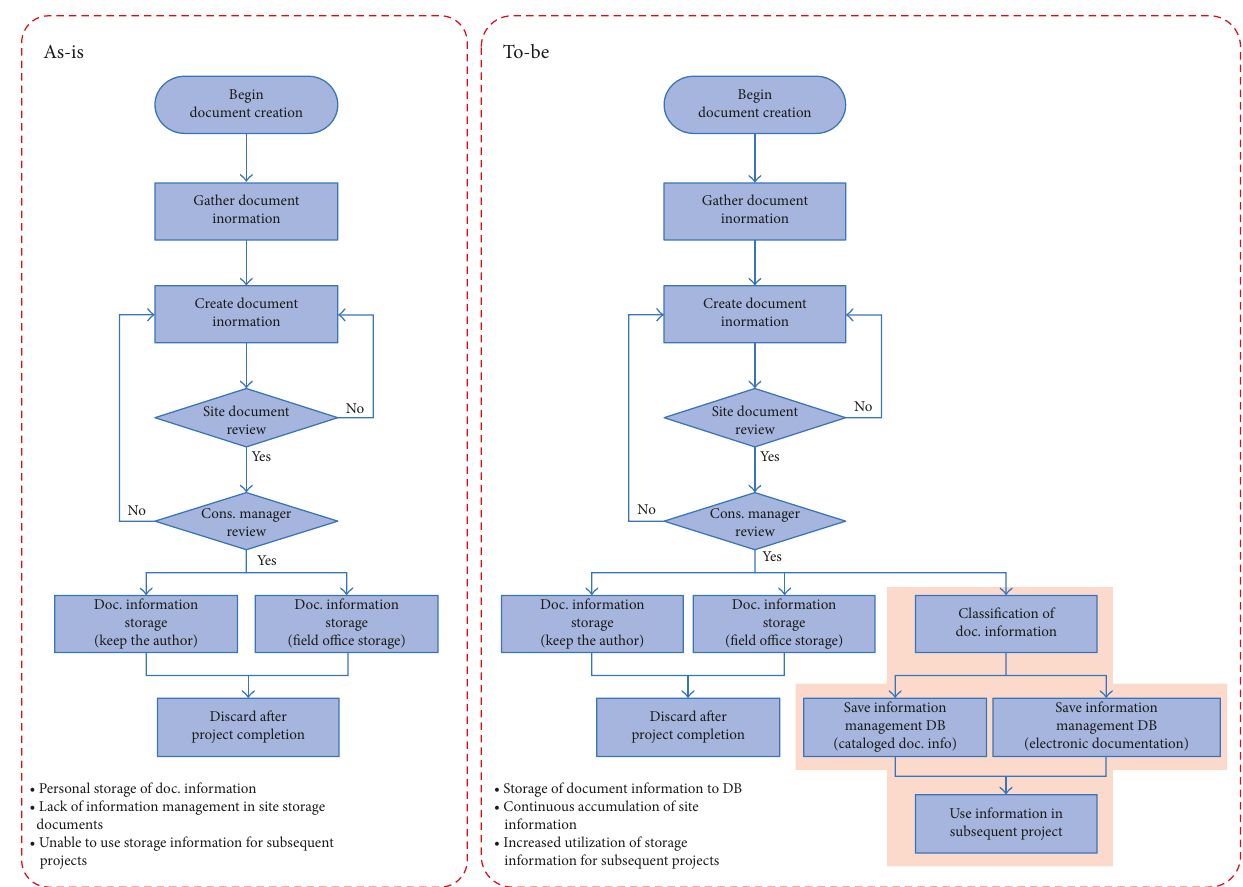
Figure 9: Comparison of document management